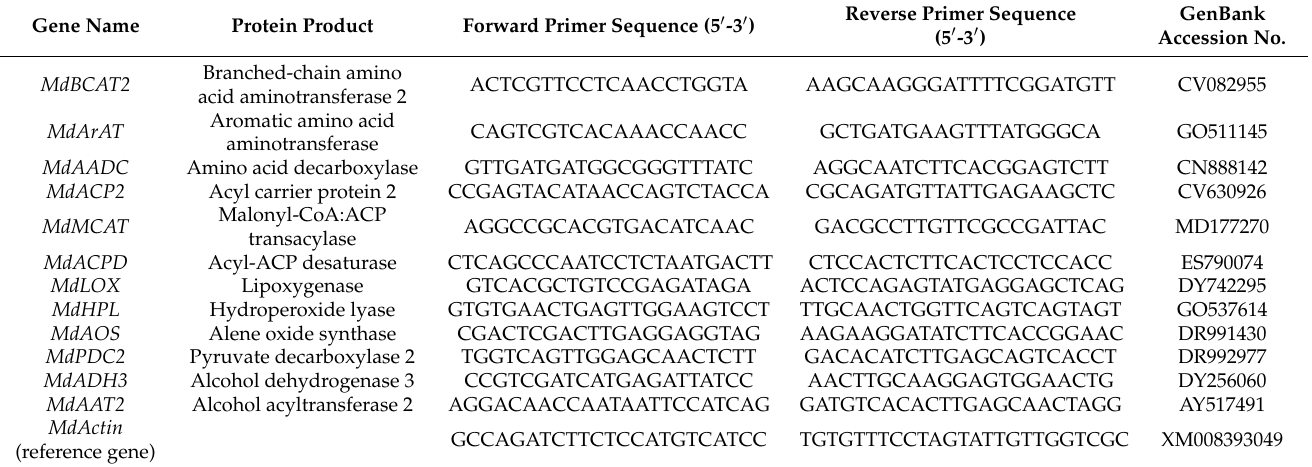
Table 3. Genes and primers used for quantitative real-time